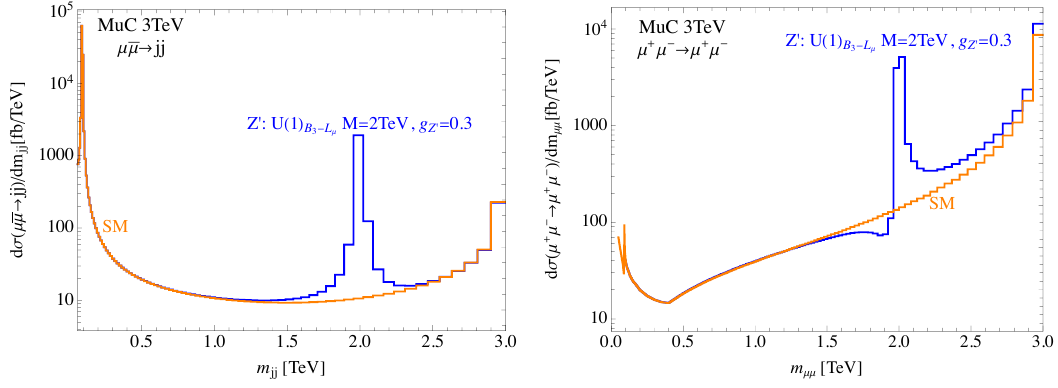
Figure 2 . Differential cross sections for inclusive IDY µ ¯ µ → jj (left) and µ + µ − → µ + µ − (right) for a 3 TeV MuC, taking into account muon PDFs. The SM cross section is shown in orange, while the prediction for a Z 0 resonance in the U(1) B model with m Z 0 = 2 TeV and coupling g Z 0 = 0 . 3 3 − L µ is shown in